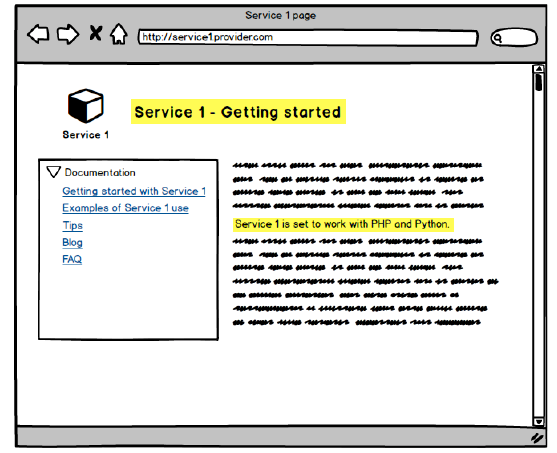
Fig. 10. Service 1 - Getting started